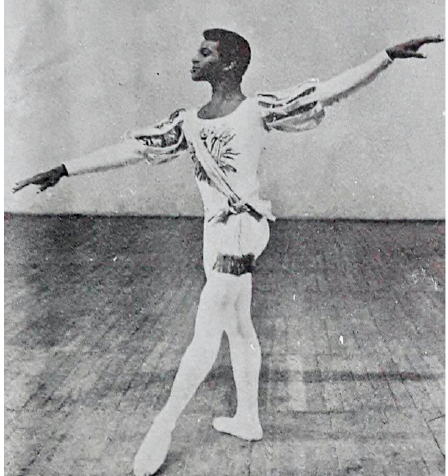
Figure 9. Andres Williams rehearses in Sleeping Beauty. 1970- е . From the personal archive of Mayumi Sakamoto de Miasnikov.